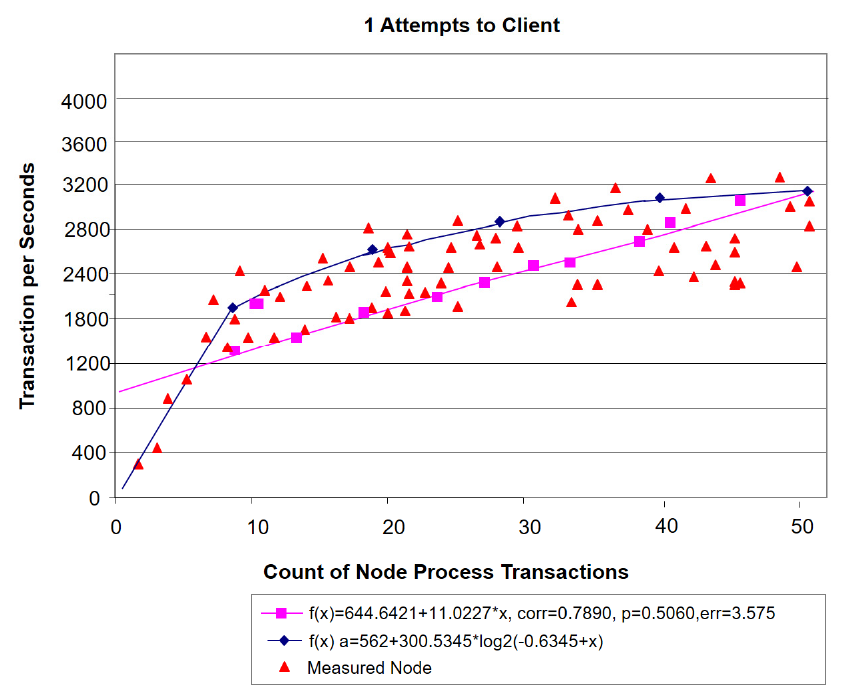
Figure 13. Existing security system application model (one round).